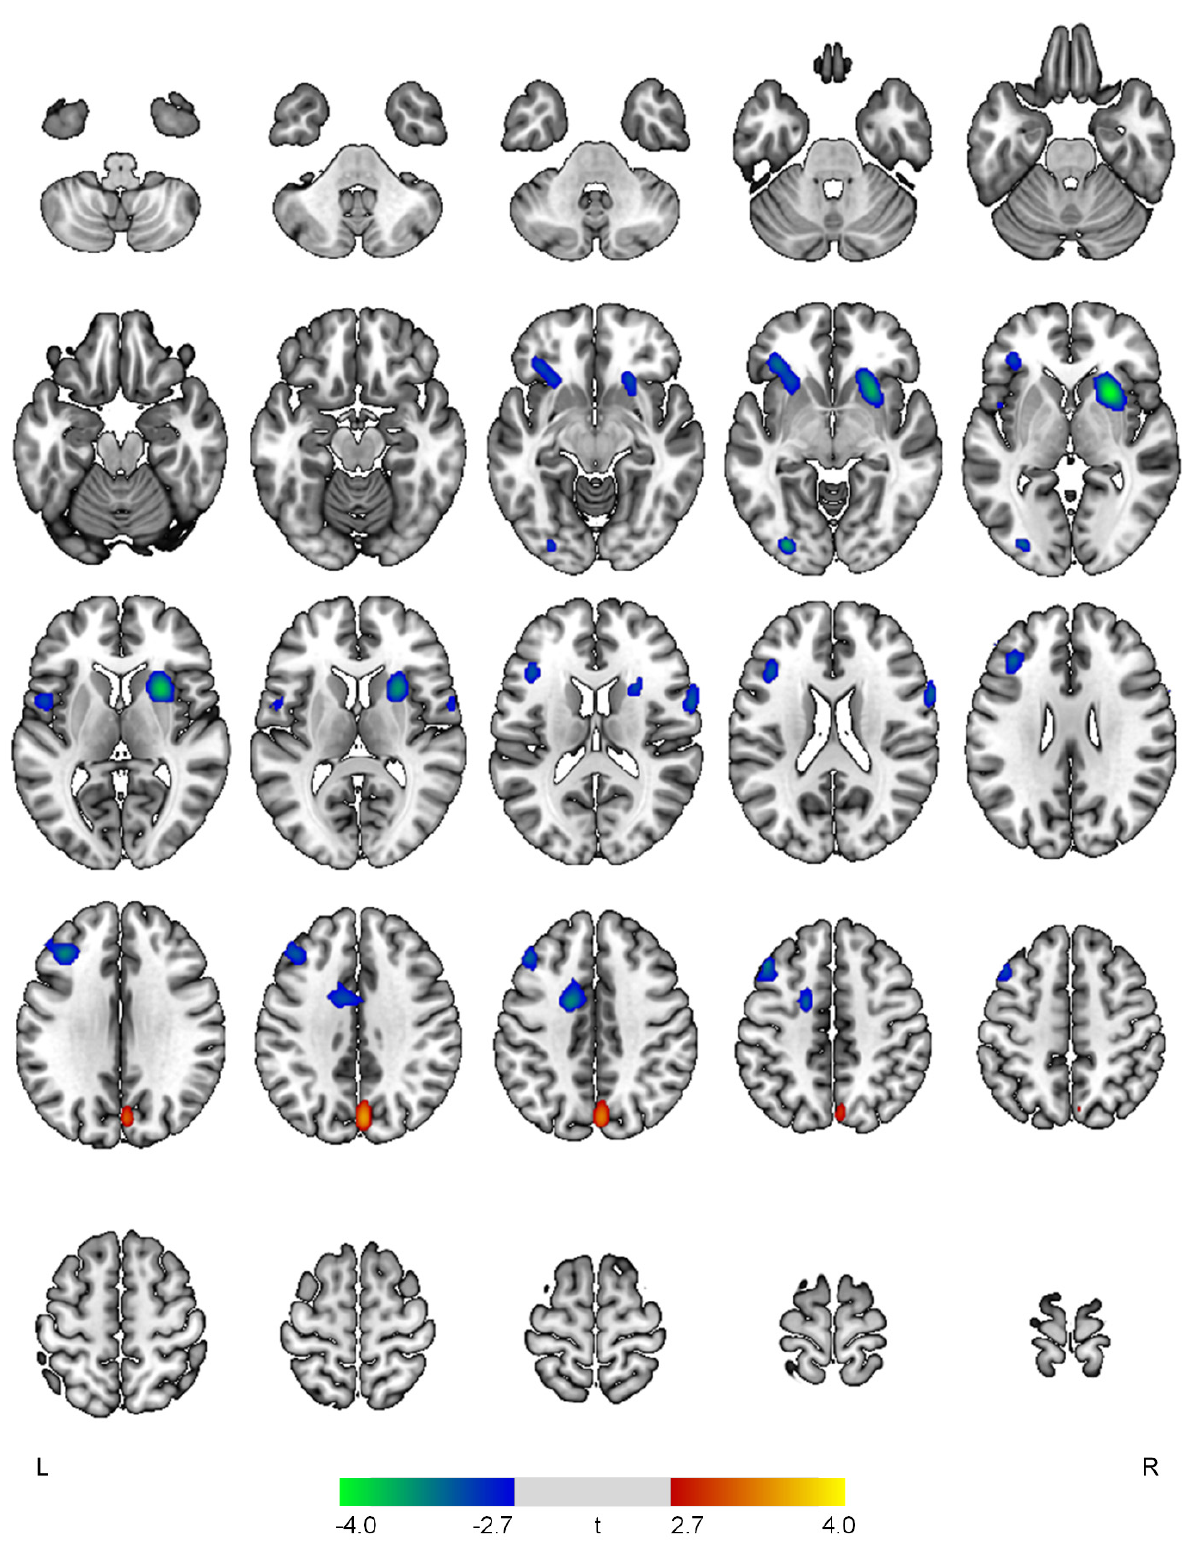
Figure 4. Positive (red-yellow) or negative (blue-green) correlations between regional cerebral blood flow and the psychosis domain in patients with early Alzheimer’s disease. The color bar represents t values at each voxel. L —left; R —right.